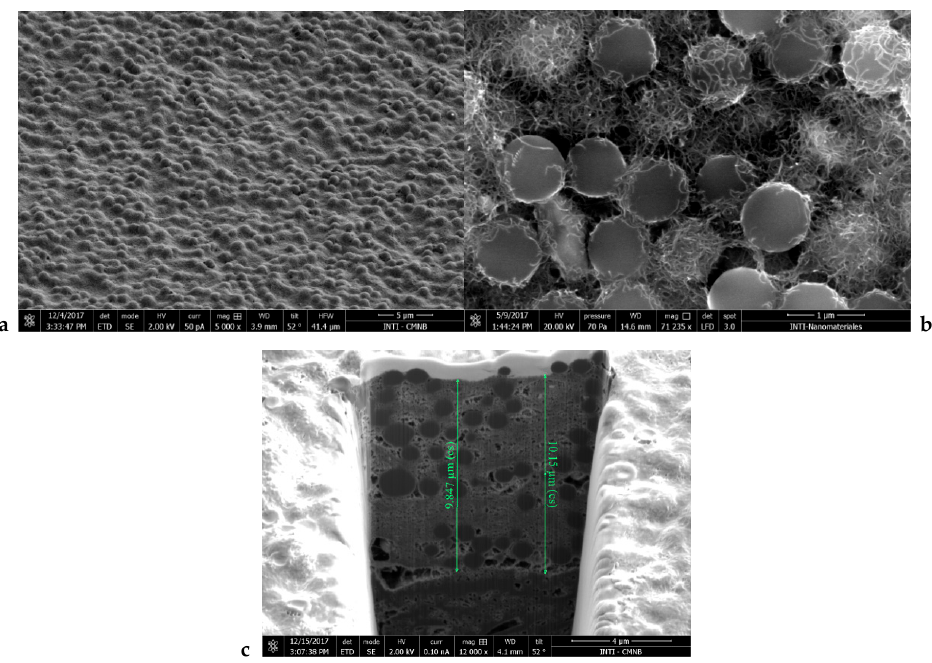
Figure 2 . Scanning electron images of electrodes printed with CNT ink with polystyrene beads at magnifications of 5000× ( a ) and 71,235× ( b ), and a cross section obtained by focused ion beam ( c ).